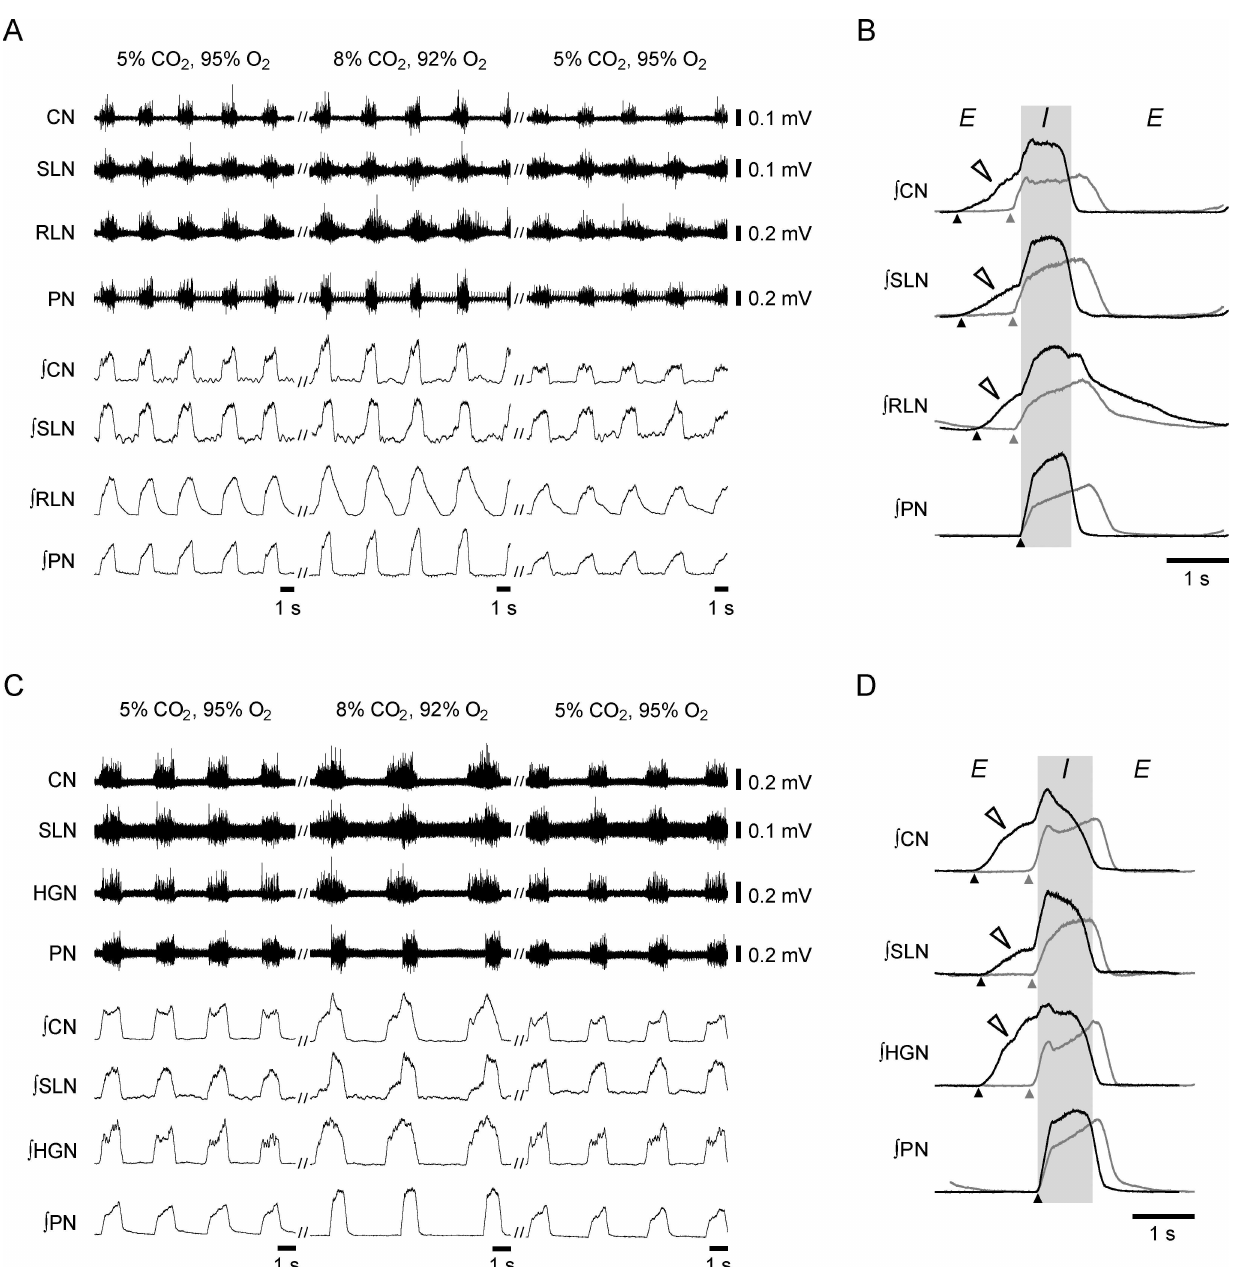
Fig 1. Respiratory motor activity under normocapnic conditions and hypercapnic acidosis. (A) Original and integratedtraces of CN, SLN, RLN, and PN activity during normocapnia (5% CO 2 , 95% O 2 ), hypercapnia (8% CO 2 , 92% O 2 ), and recovery (5% CO 2 , 95% O 2 ). (B) Traces averagedfrom consecutive integratedsweeps for 1 min in the preparation shown in (A). The black and gray traces show the averaged traces duringhypercapnia and normocapnia, respectively. The filled arrowheads show the onset of the nerve discharges. The open arrowheadsshow the pre-inspiration (pre-I) discharges. ‘ I ’ and ‘ E ’ demonstrate the inspiratoryand expiratory phases, respectively.(C) Original and integratedtraces of the CN, SLN, HGN, and PN activity obtainedfrom a different preparation from (A). (D) Traces averaged from consecutiveintegrated sweeps for 1 min in the preparation shown in